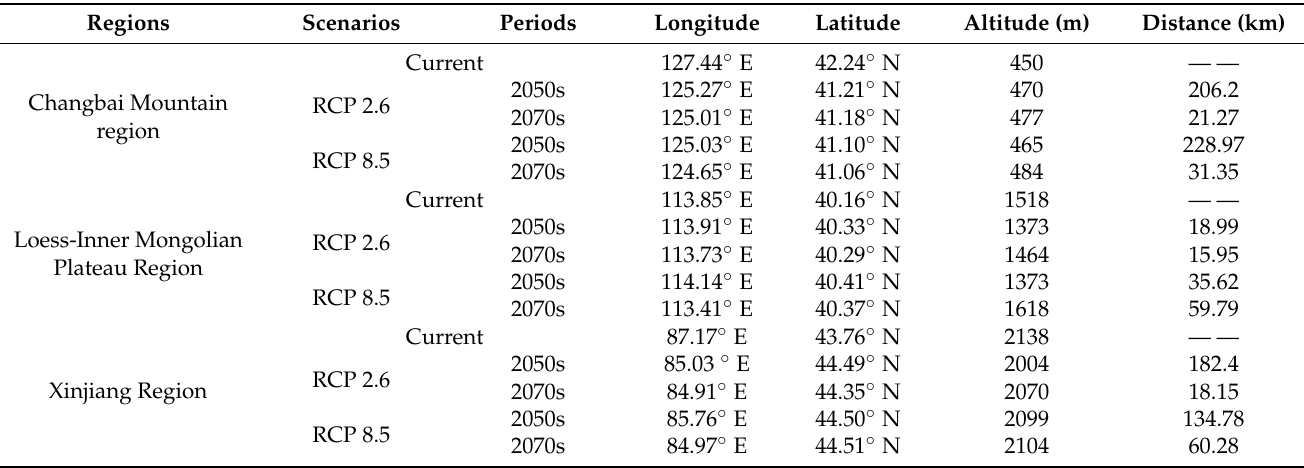
Table 4. The geographic coordinates of the core areas and the average elevation of the suitable regions. The distances represented the migration distance relative to the previous time point. The altitude means the average elevation of the core